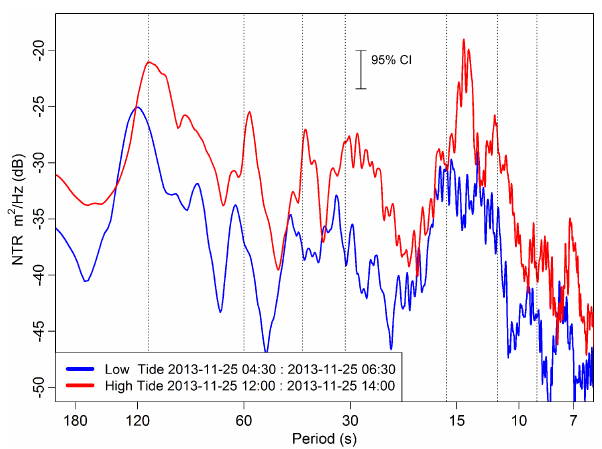
Figure 9. PSD estimates of 1Hz NTR data from 2h periods cen- tered on low and high water of a tidal period. Offshore waves were low during this period. Dotted vertical lines mark harbor modes at 112, 60, 41, 31, 16 and